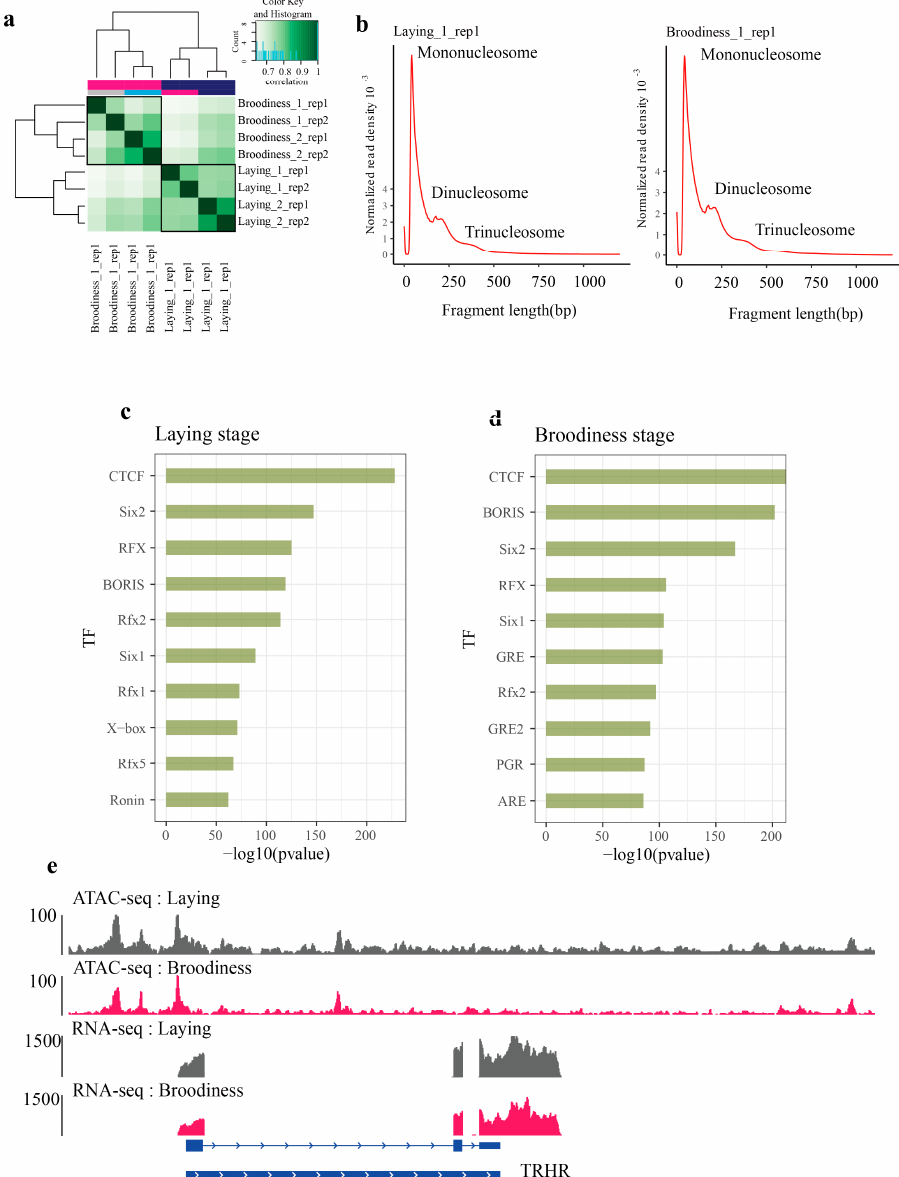
Figure 2. The quality control of ATAC-seq and characteristic of chromatin accessibility in goose pituitary at the genome-wide level. ( a ) The Pearson correlation heat maps show correlations between all ATAC-seq libraries, with biological replicates at laying and broodiness stages clustered together separately and with high consistency between technical replicates. ( b ) The curve graph shows the number of length changes in insertion fragments in ATAC-seq library. The highlighted peaks represent mononucleosome, dinucleosome, and trinucleosome, respectively, showing the standard pattern of length of insertion fragments in ATAC-seq library. ( c ) The histogram shows